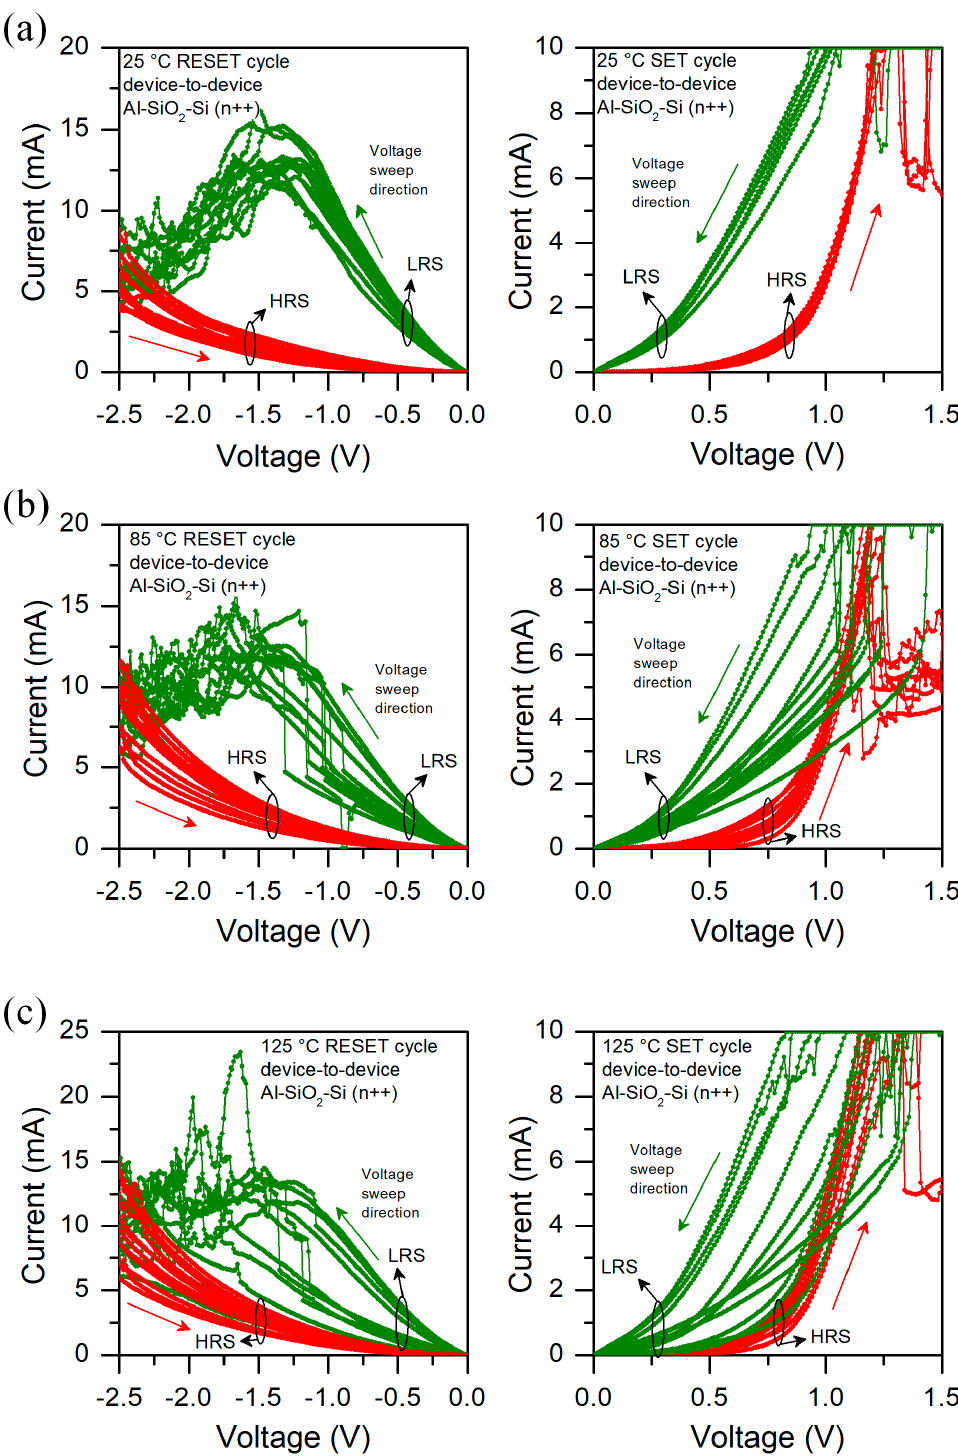
Figure 7. I-V characteristics of Al/SiO 2 /n++-Si RRAM device measured at ( a ) 25 ◦ C, ( b ) 85 ◦ C, and ( c ) 125 ◦ C for six different structures. Arrows indicate the voltage sweep direction, LRS is marked in green color, whereas HRS in red color.